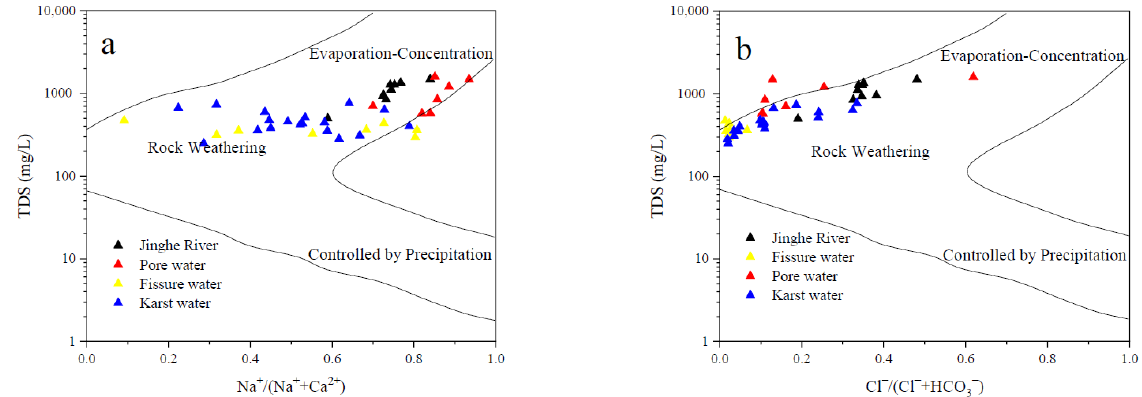
Figure 3. Gibbs diagram of different water bodies.